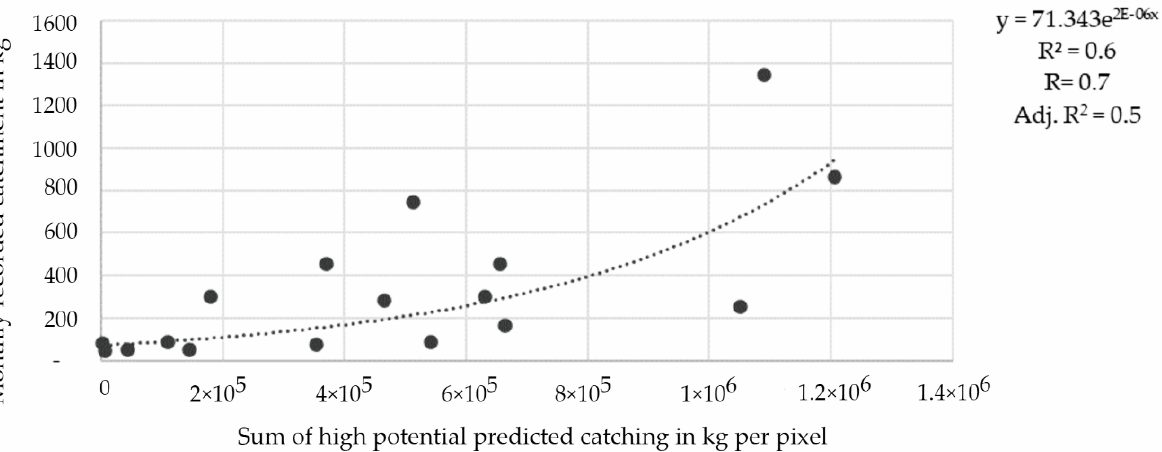
Figure 7. Relationship between predicted and observed catches (kg).